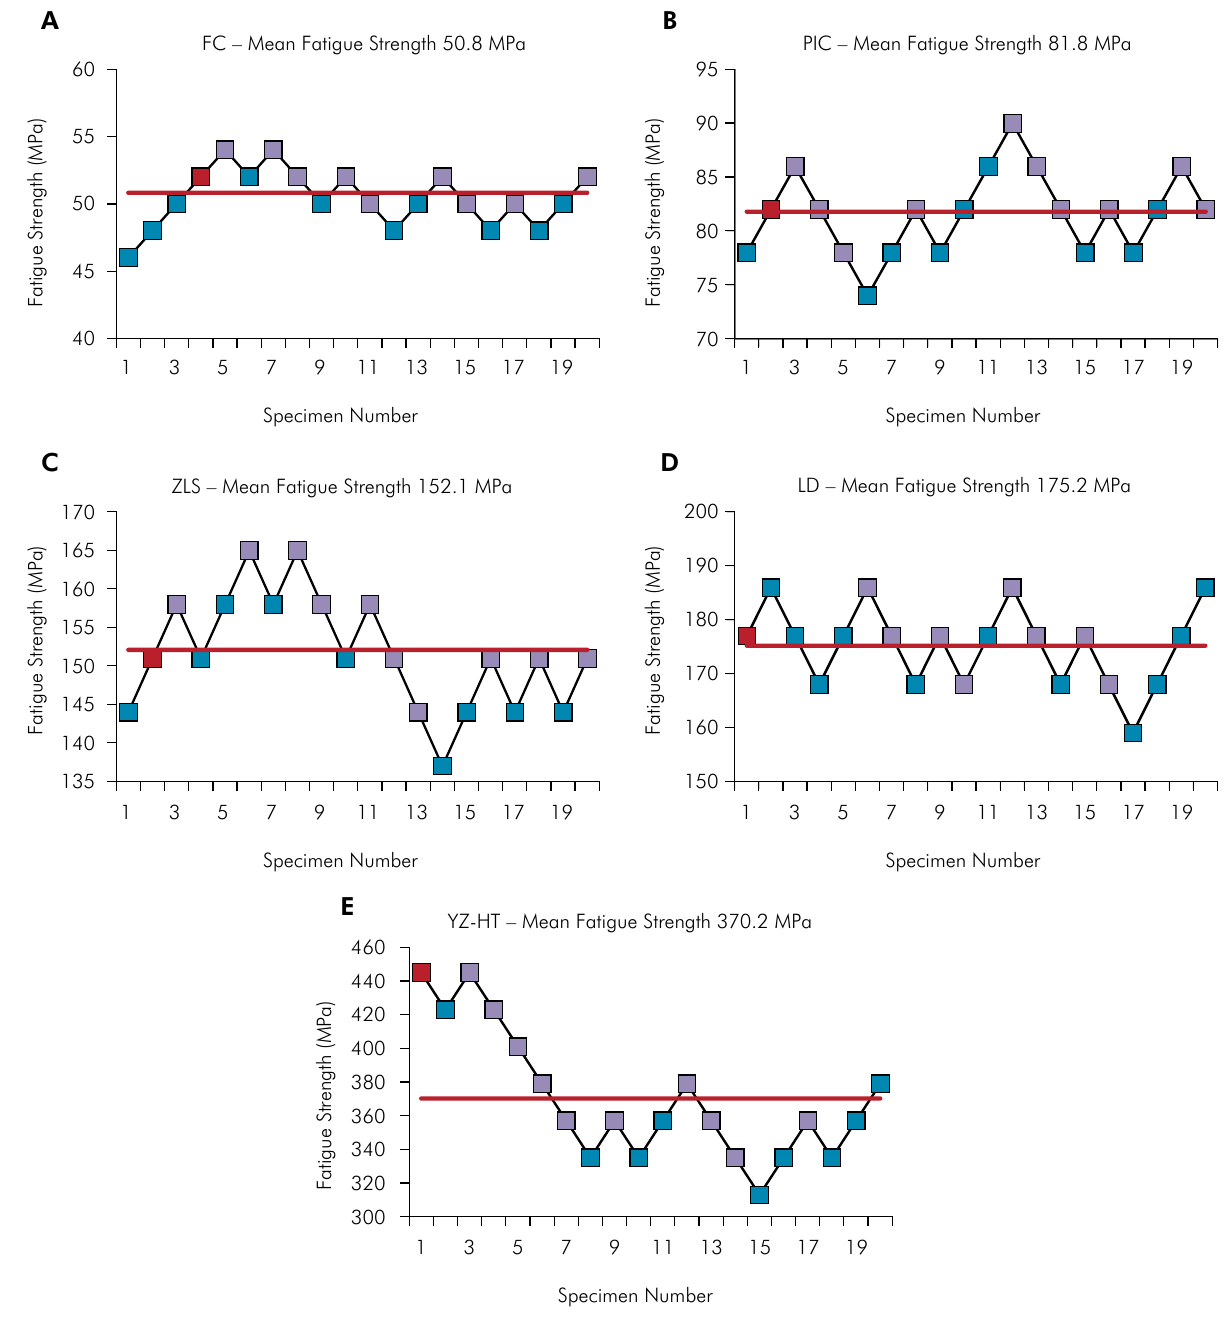
Figure 1. Staircase sensitive results after 100,000 cycles at 10 Hz. The lines indicate the mean fatigue strength, the blue shaded elements indicate the surviving specimens, the purple indicate fractured specimens, and the red ones indicate the specimen on which the staircase initiated according to